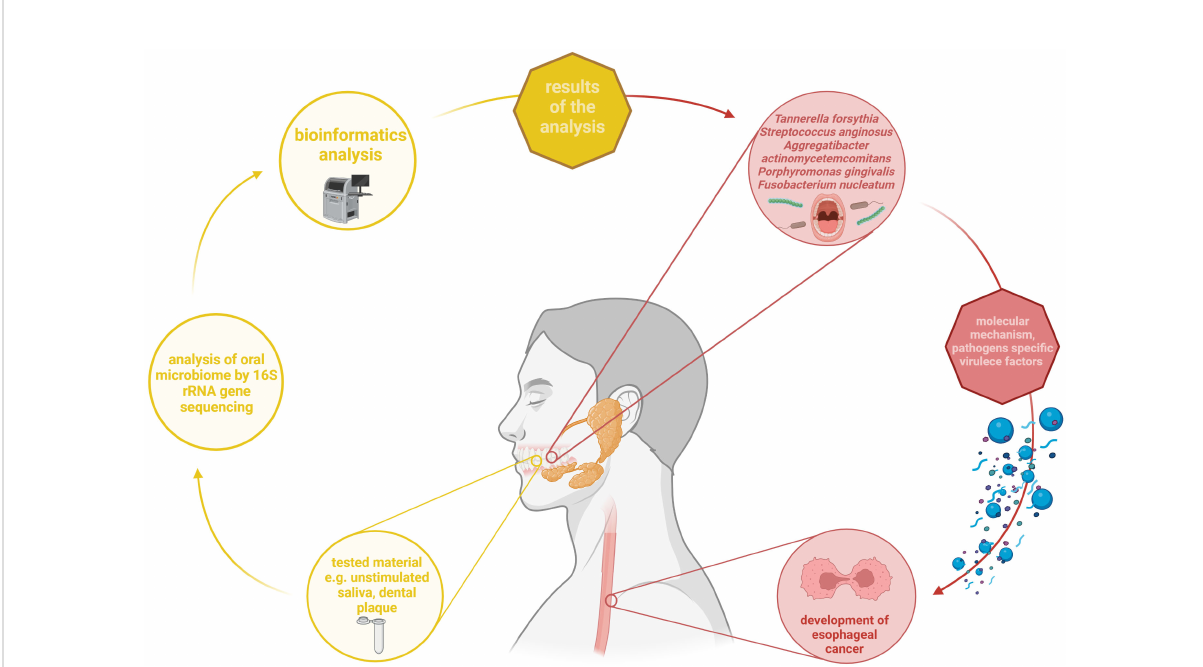
FIGURE 3 Summary of the relationship between changes in the oral microbiota and development of esophageal cancer. Based on up-to-date studies, some of bacteria such as T. forsythia , S. anginosus , A. actinomycetemcomitans , P. gingivalis , and F. nucleatum may contribute to esophageal cancer occurrence. They are characterized by presenting speci fi c virulence factors that allow them to participate in this process. In most reviewed studies, oral microbiome was analysed from dental plaque and unstimulated saliva was analysed using 16S rRNA gene sequencing. Own elaboration based on the literature (Yamamura et al., 2016; Johansson et al., 2019; Chinthamani et al., 2021). This fi gure was created using Biorender.com